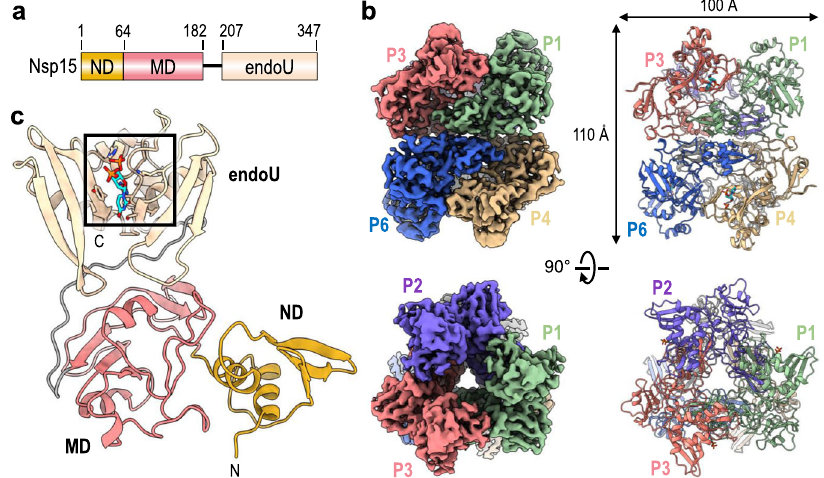
Fig. 1 Architecture of hexameric SARS-CoV-2 Nsp15. a Domain organization of Nsp15. The numbering corresponds to the amino acid residues at the domain boundaries. The Nsp15 N-terminal domain (ND) is shown in orange, the middle domain (MD) is shown in red, and the poly-U-speci fi c endonuclease domain (endoU) is shown in beige. b Orthogonal views of the cryo-EM map reconstruction of UTP-bound Nsp15 (left) and its corresponding model shown as a cartoon (right). Each Nsp15 protomer is colored as green (P1), purple (P2), coral (P3), tan (P4), gray (P5), and blue (P6). c Model of Nsp15 protomer shown as a cartoon and colored as seen in ( a ). The position of the Nsp15 endoU active site is highlighted with a black box and the modeled nucleotide is shown as sticks (cyan). N and C mark the N- and C-termini,